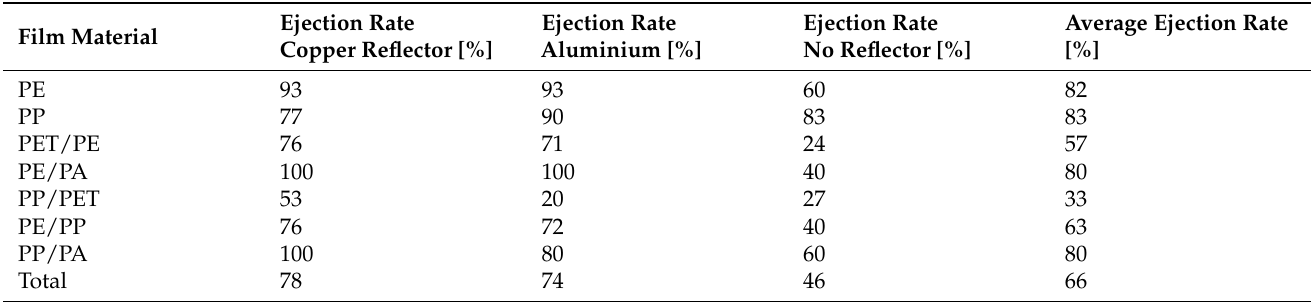
Table 3. Ejection rates with different